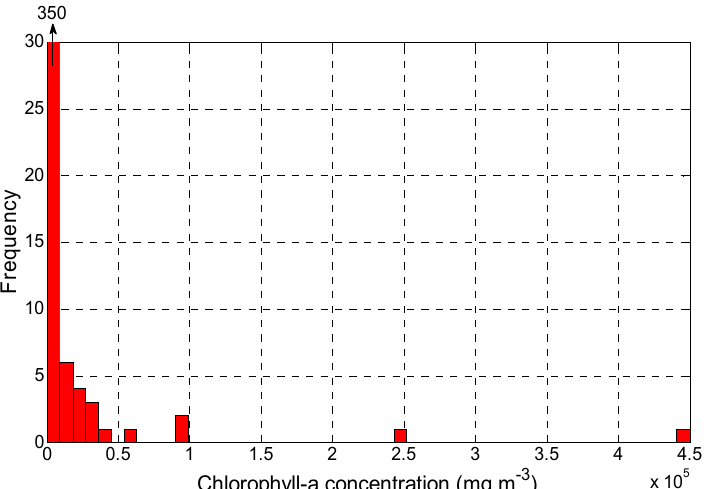
Figure 3. Histogram of the frequency of chlorophyll-a values observed (complete data set, N =